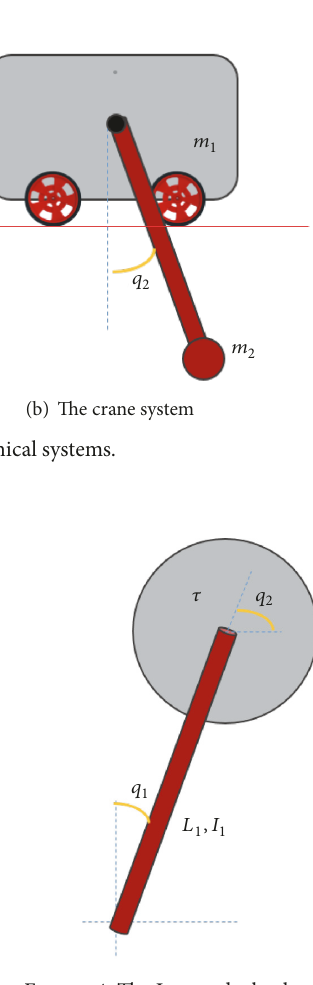
Figure 4: The Inverted wheel pendulum.